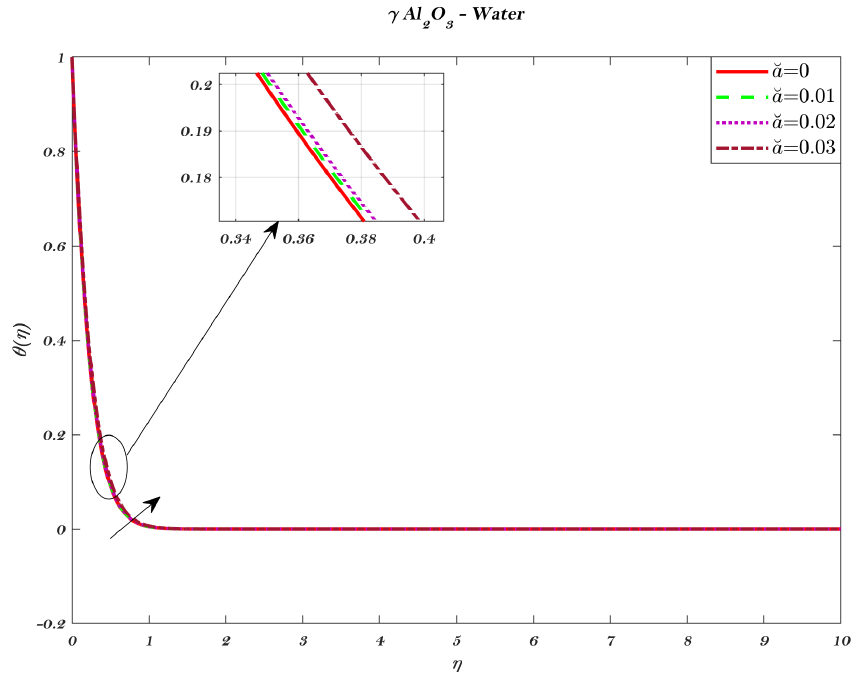
Figure 13. The slip parameters ˘ a against η on the temperature profile with ϕ = 2%, (cid:101) = 0.01 and R =